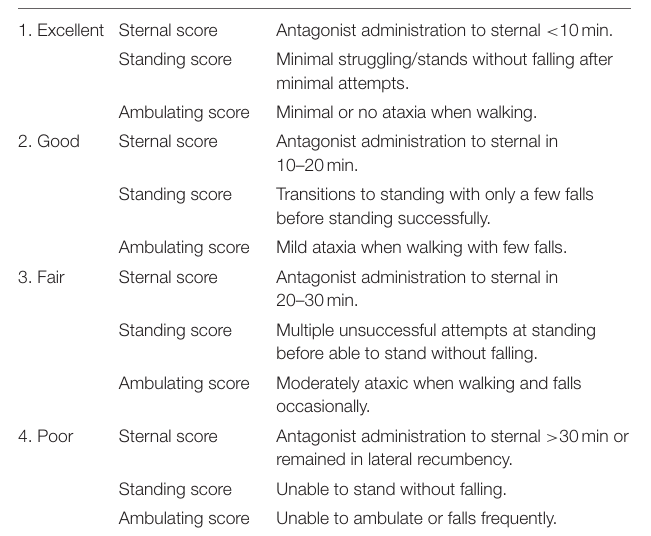
TABLE 2 | Recovery scoring system.